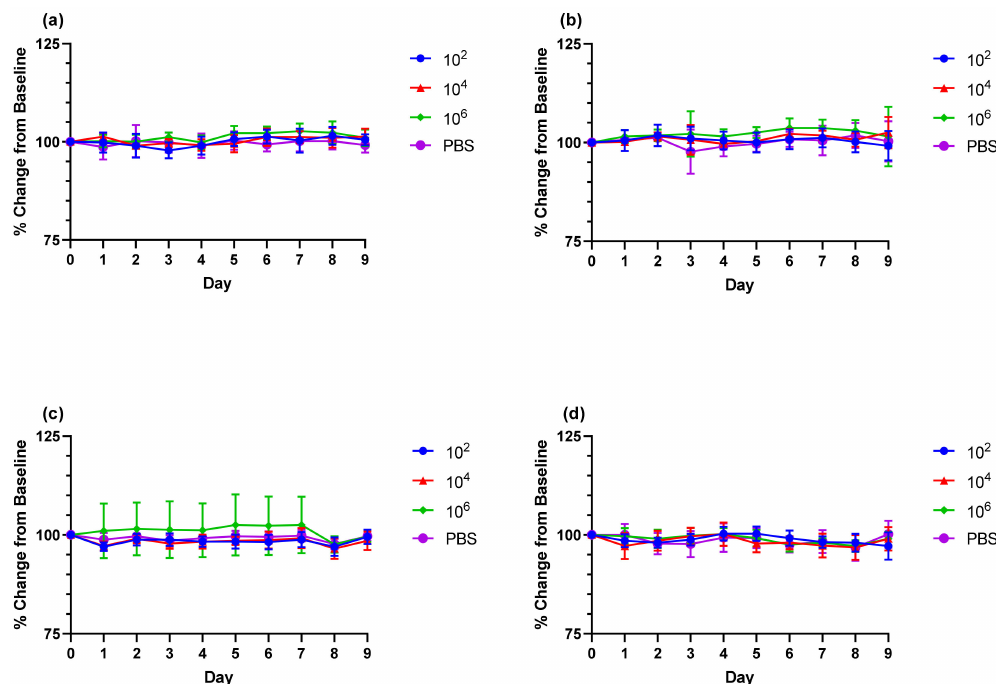
Figure 2. Changes in body weight and body temperature in C57BL/6J mice challenged with CHIKV morr/3 (cid:48) del vs. AF15561 viruses. Percent change in body weight from baseline (day 0) following challenge with CHIKV morr/3 (cid:48) del ( a ) or CHIKV AF15561 ( b ). Percent change in body temperature from baseline following challenge with CHIKV morr/3 (cid:48) del ( c ) or CHIKV AF15561 ( d ).